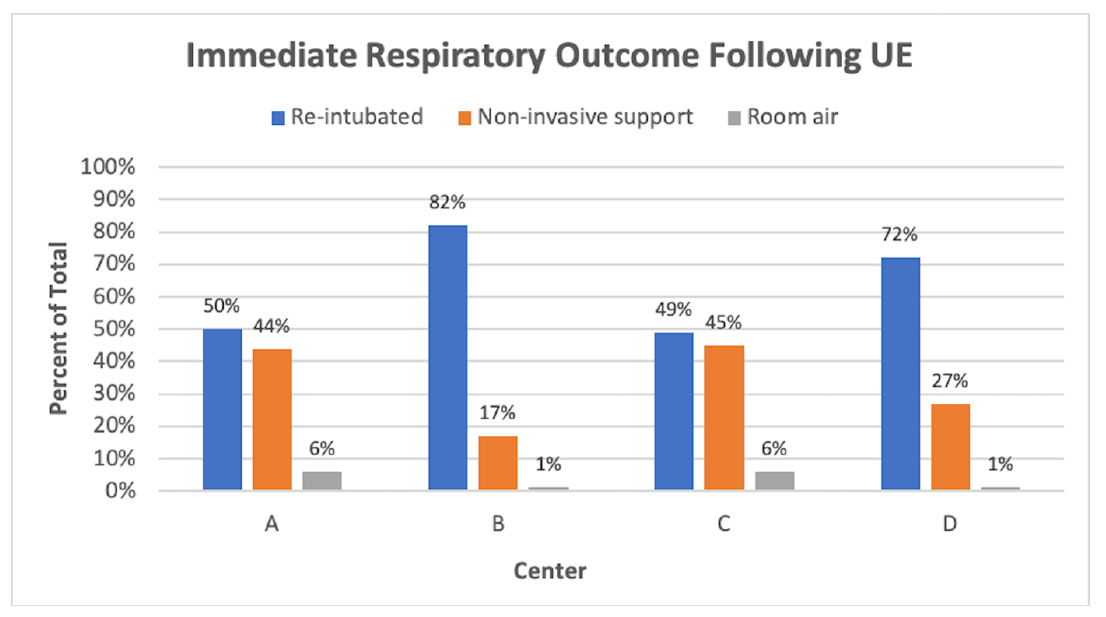
Figure 8. Percent of UEs that resulted in immediate reintubation, placement of infant on non-invasive respiratory support, or transition to no respiratory support (room air) at each center.